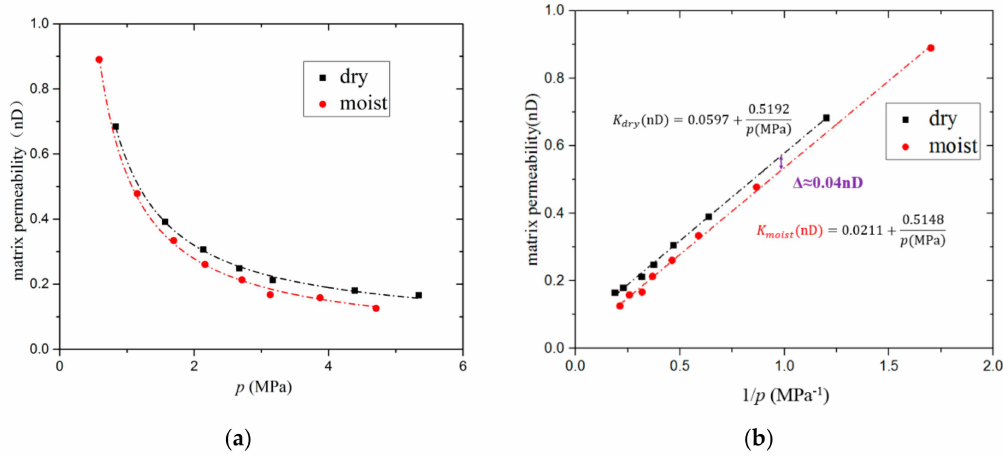
Figure 11. Matrix permeability of dry and moist (1.5% water) samples of shale sample 1 under di ff erent pressures. ( a ) Matrix permeability vs. pressure. The dotted lines are the results of fitting using the Klinkenberg equation. ( b ) Matrix permeability vs. 1 / p